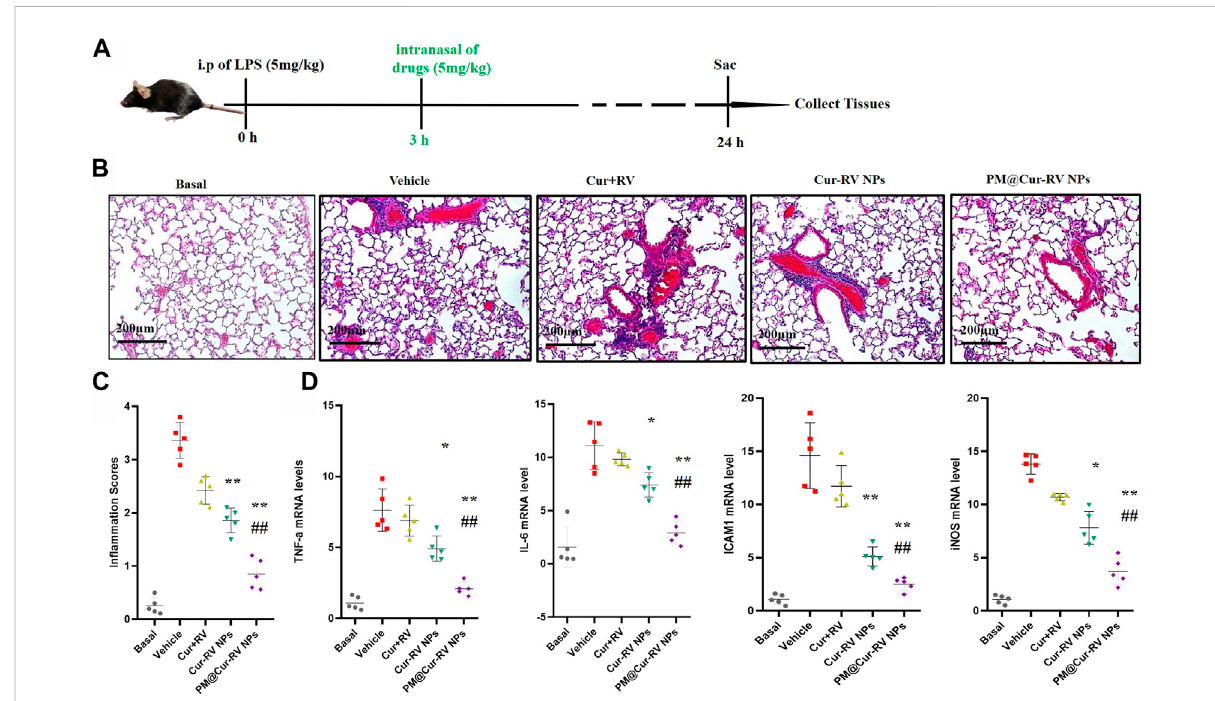
FIGURE 5 Cur-RV NPs, especially PM@Cur-RV NPs signi fi cantly promote resolution of lung in fl ammation in LPS-induced septic mice. (A) Time-axis of lungin fl ammationdetermination.ThemicewereintranasallyadministrateddifferentformulationsofCurandRVat3 hpost-LPSchallenge(5 mg/kg), and bronchiolar alveolar lavage fl uid (BALF), blood, and lung tissues were collected at 24 h post-LPS challenge (5 mice/group). (B) Representative micrographs of lung tissue cross-sections at 24 h post-LPS challenge stained by H&E. Magni fi cation (×400). (C) In fl ammation scores in the